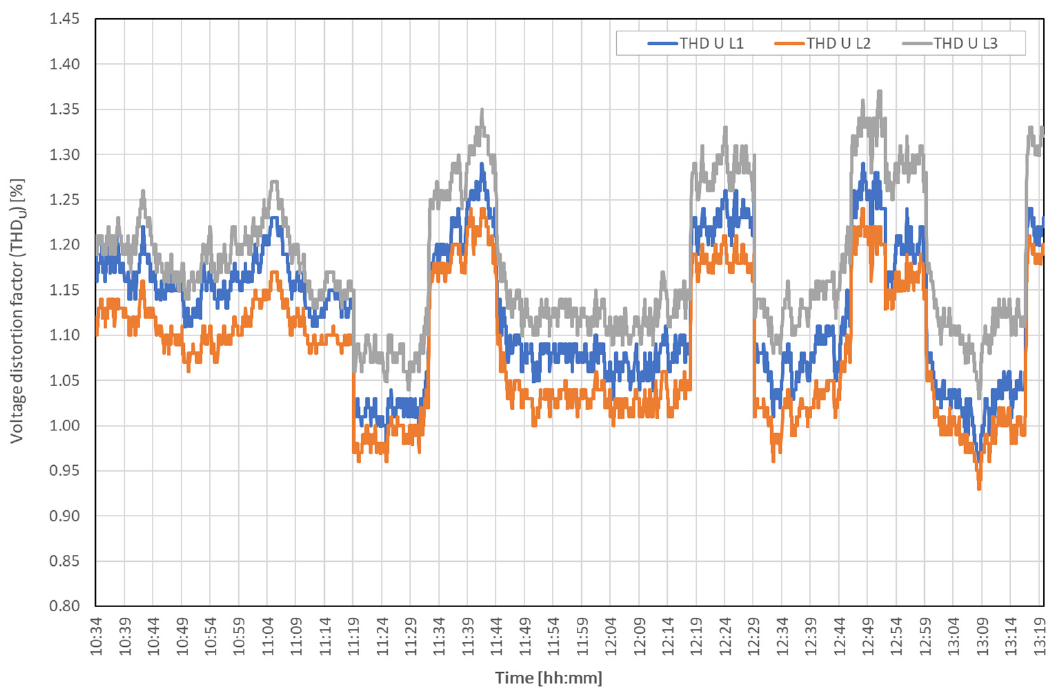
Figure 9. Time course of the voltage distortion factor (THD U ) at the connection point of a wind power plant.